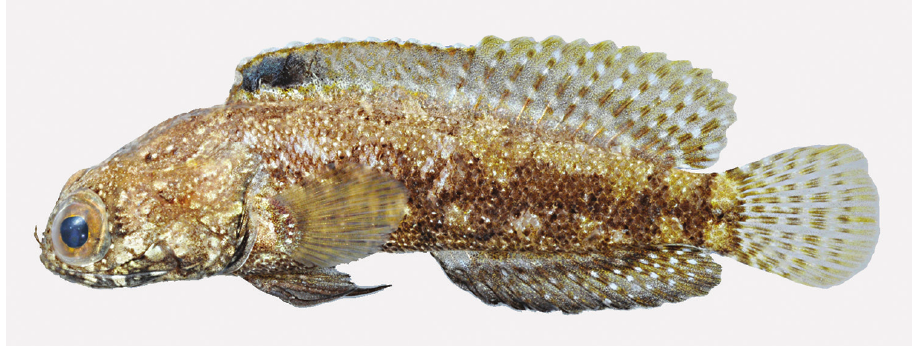
Figure 11. Opistognathus whitehursti , UF 183105, 43.0 mm SL, St. Croix. Photograph by Howard L.